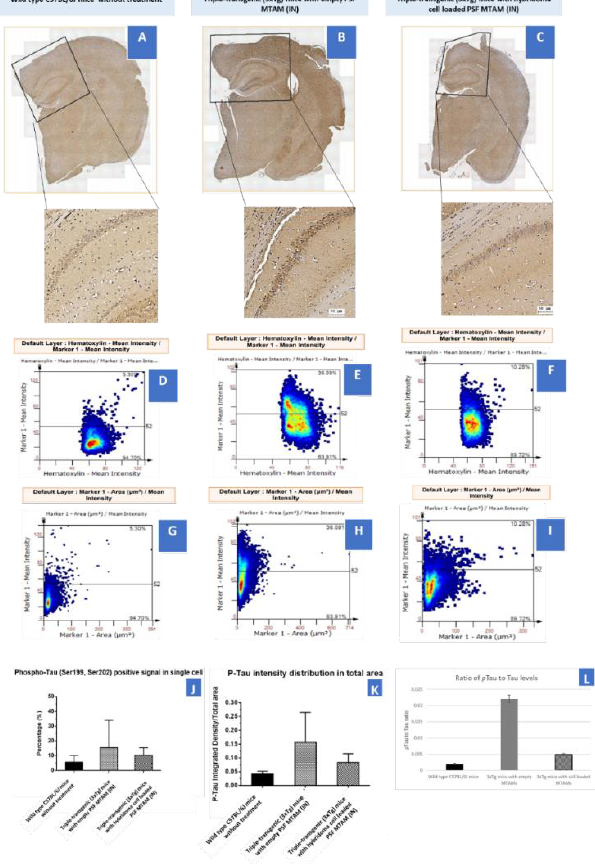
Figure 7. ( A – C ) Tissue section of the brain of mouse models of wild-type C57BL/6J mice without treatment ( n = 5), Triple-transgenic (3xTg) mice with empty PSF MTAM (IN; n = 3), and Triple-transgenic (3xTg) mice with hybridoma cell loaded PSF MTAM (IN; n = 4) along with the corre- sponding magnified sections. P-Tau (detected via Ser199/Ser202 antibodies) appeared to be brown in color. ( D – F ) Percentage of P-Tau positive signal in a single cell (y-axis) with hematoxylin signal